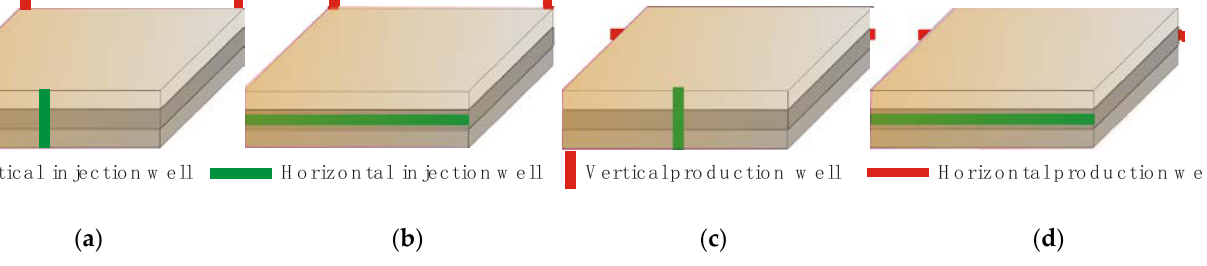
Figure 1. Illustrations of 3D simulation physical model: ( a ) vertical well pattern, ( b ) injection with horizontal well and production with vertical well, ( c ) injection with vertical well and production with horizontal well, and ( d ) horizontal well pattern .